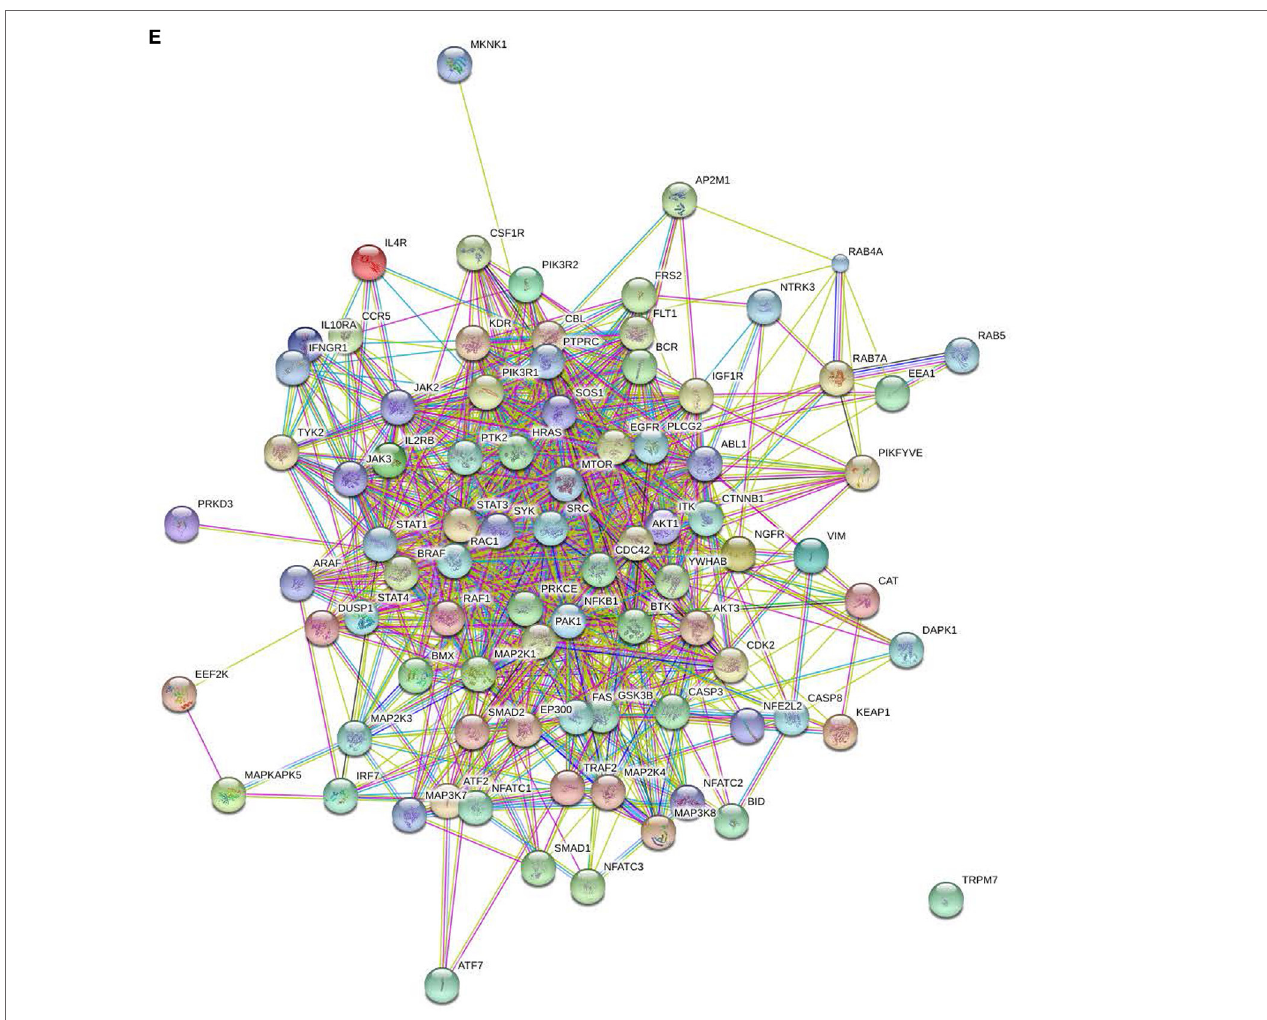
FigUre 2 | Protein–protein interactions. Predicted protein–protein interactions generated following analysis of significantly different peptides input into the STRING database: (e) late low interactions.